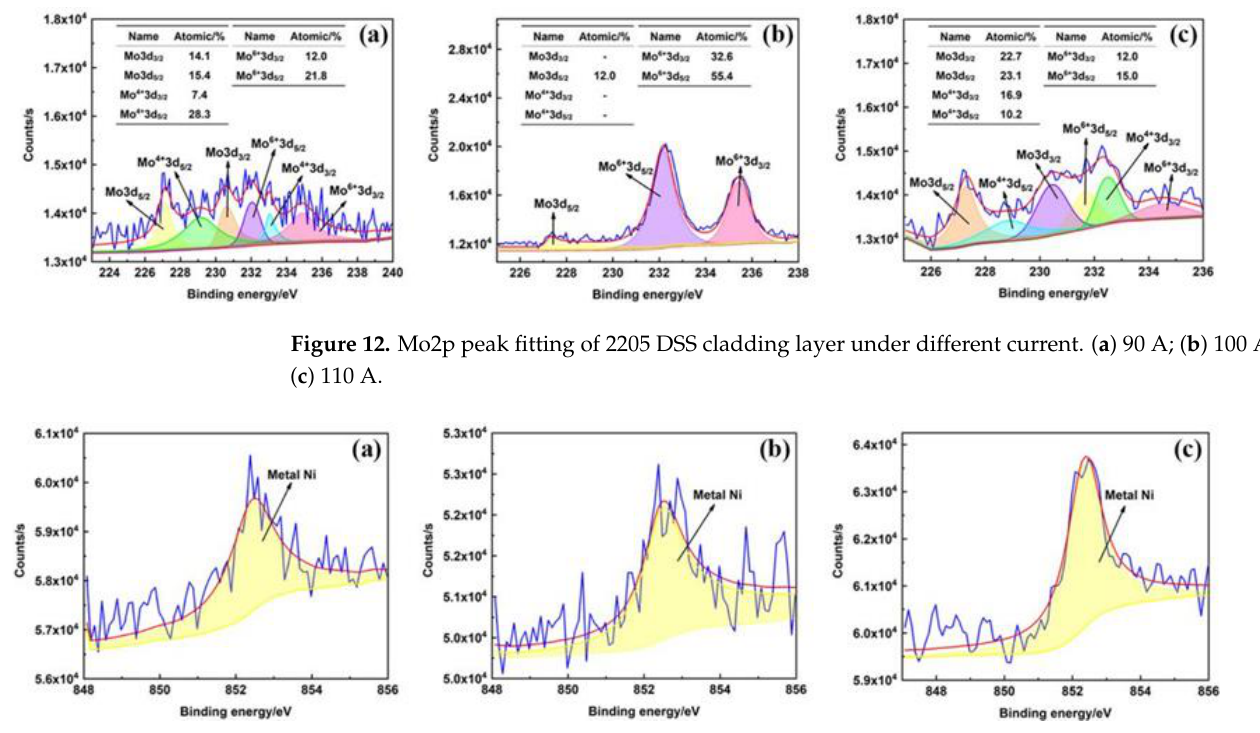
Figure 14. O2p peak fitting of 2205 DSS cladding layer under different current. ( a ) 90 A; ( b ) 100 A; ( c ) 110 A. When the cladding layer sample was immersed in 3.5% NaCl solution, a corrosion mirocell was formed on the surface of the sample. The depolarization reaction of oxygen took place at the cathode of micro cell, as shown in formula (1). In contrast, the dissolution reaction of the metal matrix (Fe, Cr) occurred at the anode of micro cell, as shown in for- mula (2~9) [32,33]. Based on EET theory, the smaller the covalent electrons number of the strongest bond, the easier it is to form a new phase [32]. Many previous literatures has proved that the covalent electron number n A of the strongest bond of Cr 2 O 3 is 0.95284, while n A of Fe 2 O 3 is 1.12898. Obviously, the n A of Cr 2 O 3 is smaller. Therefore, OH − in the corrosion solution is adsorbed to the surface of cladding layer, it preferentially reacts with Cr to form Cr 2 O 3 , and then it interacts with Fe to form Fe 2 O 3 and FeO. Cathode reaction: